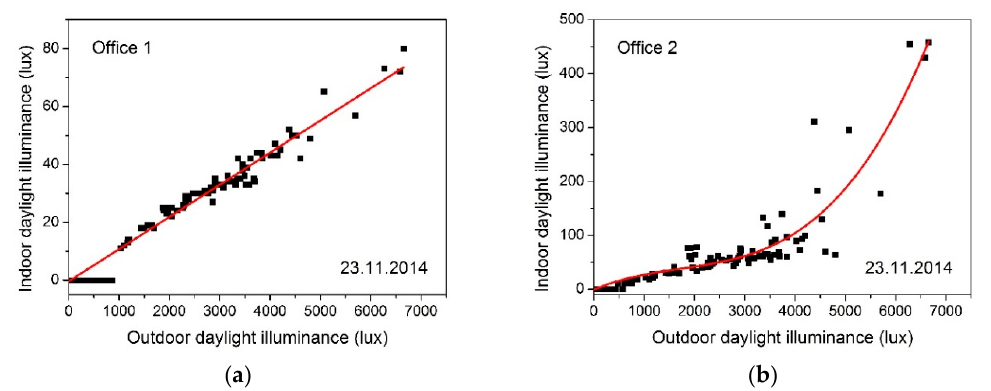
Figure 8. Relationships between internal and external illuminance of daylight measured by weather station on cloudy day on 23 November 2014 for ( a ) Office 1 and ( b ) Office 2.